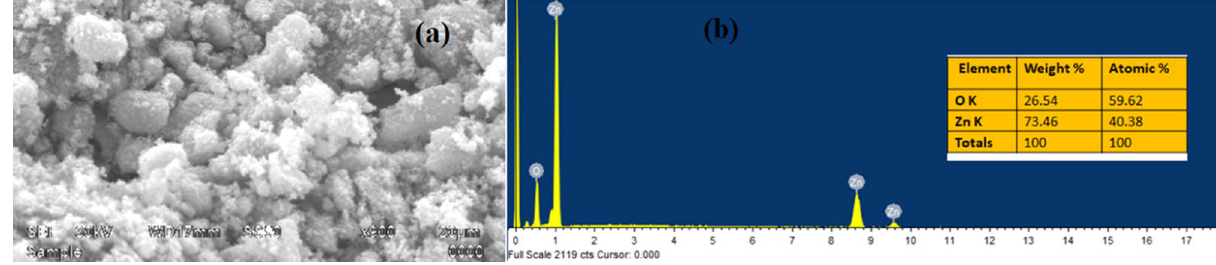
Fig. 8 a SEM image and b EDS spectrum of ZnO